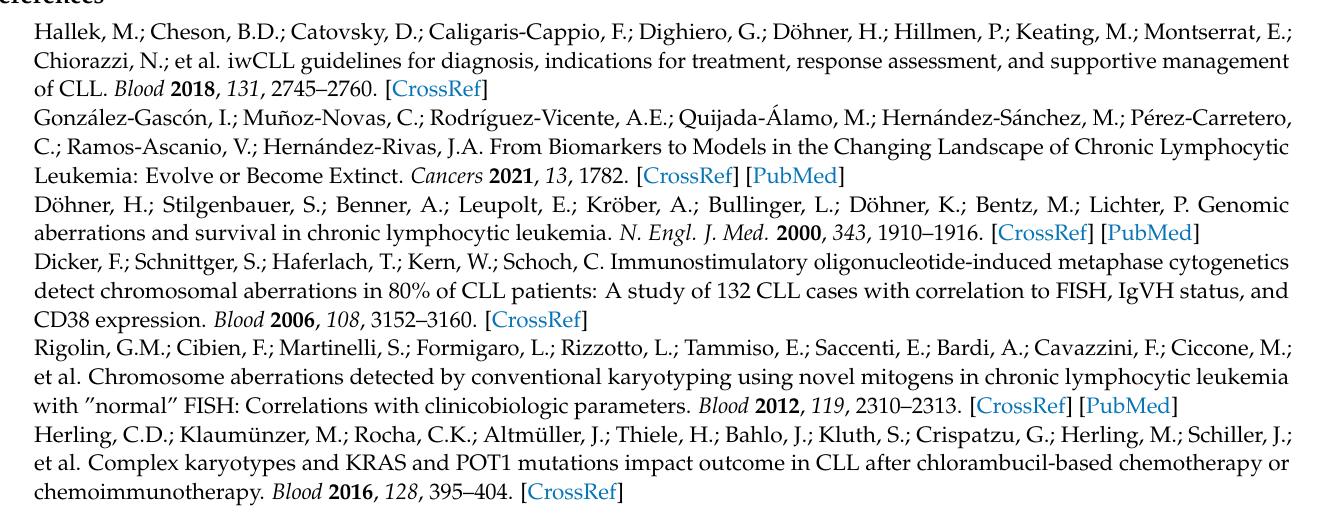
Figure S2. Examples of novel translocations called by OGM that were associated with known CNVs previously identified by CMA. Figure S3. Distribution of the number of abnormalities detected in non-CK and CK groups. Figure S4. Example of two of the high-risk patients by CBA and/or CMA with less than 10 abnormalities detected by OGM. Figure S5. Kaplan–Meier plots for time to first treatment (TTFT) based on the presence of genomic complexity detected by OGM. Table S1. FISH probes tested to validate OGM results. Table S2. Technical performance of OGM in the whole cohort. Table S3. Detailed information on the detection of the 309 known abnormalities by OGM. Table S4. Summary of the interchromosomal translocation calls detected by OGM and comparison with CBA and FISH